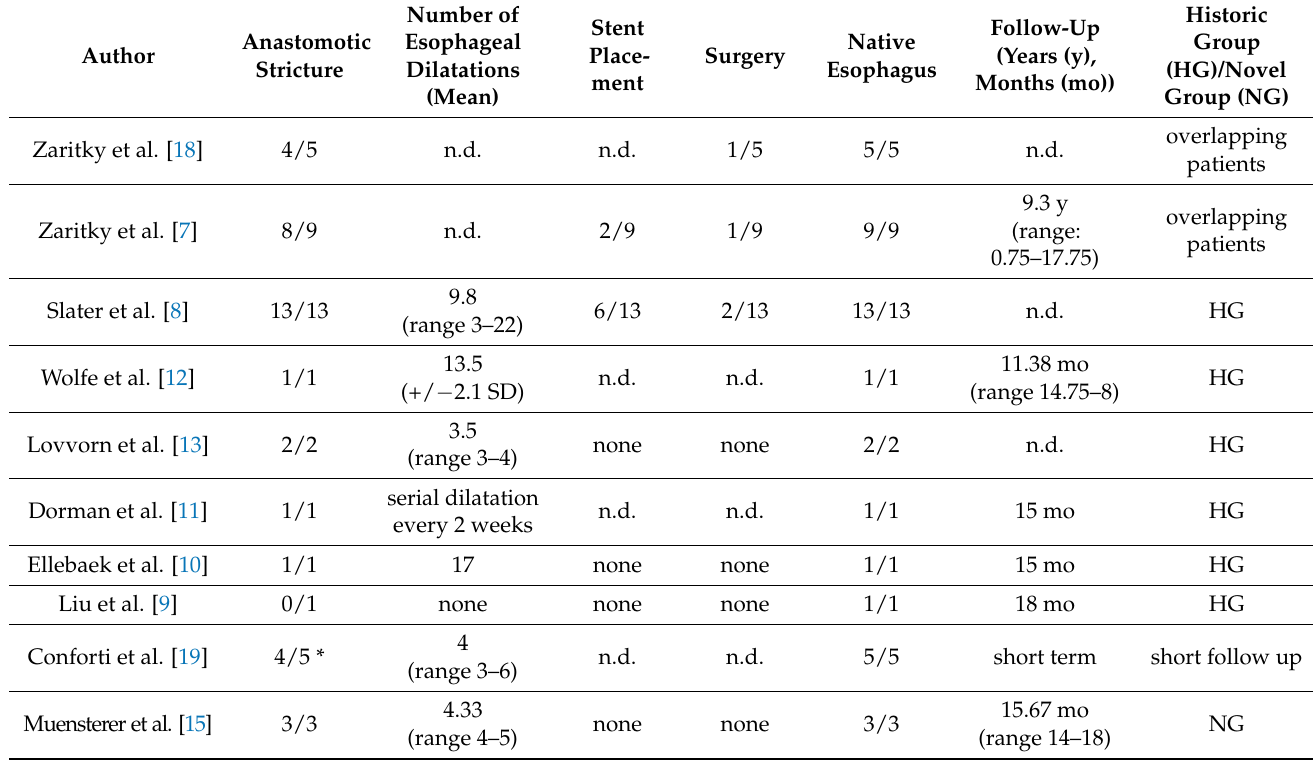
Table 3. Outcomes of magnetic esophageal compression